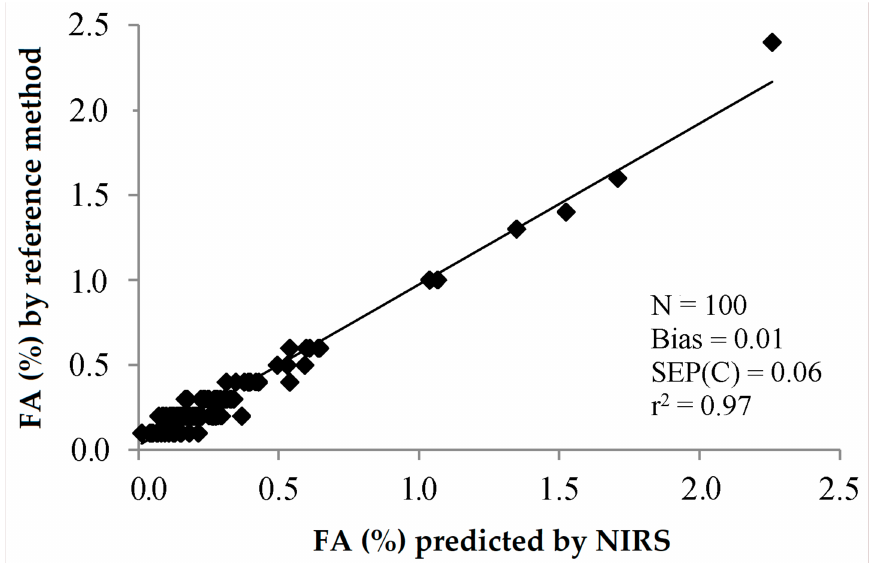
Figure 7. Validation exercise for the determination of the free acidity of olive oil by PLS-NIRS using all the wavelengths between 400 and 2500 nm